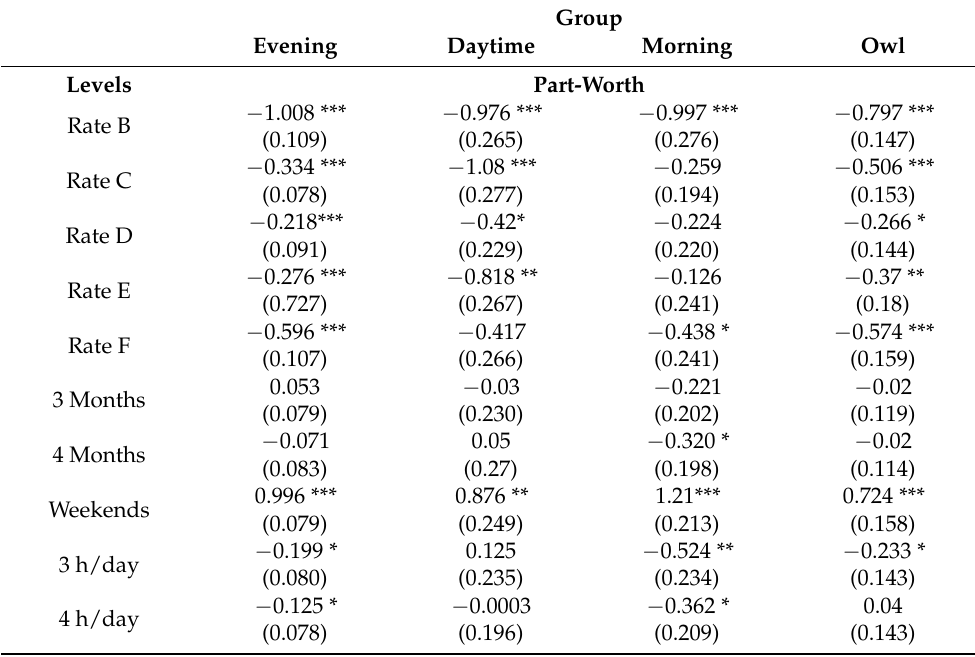
Table 5. Estimation of choice experiment using the mixed logit model.